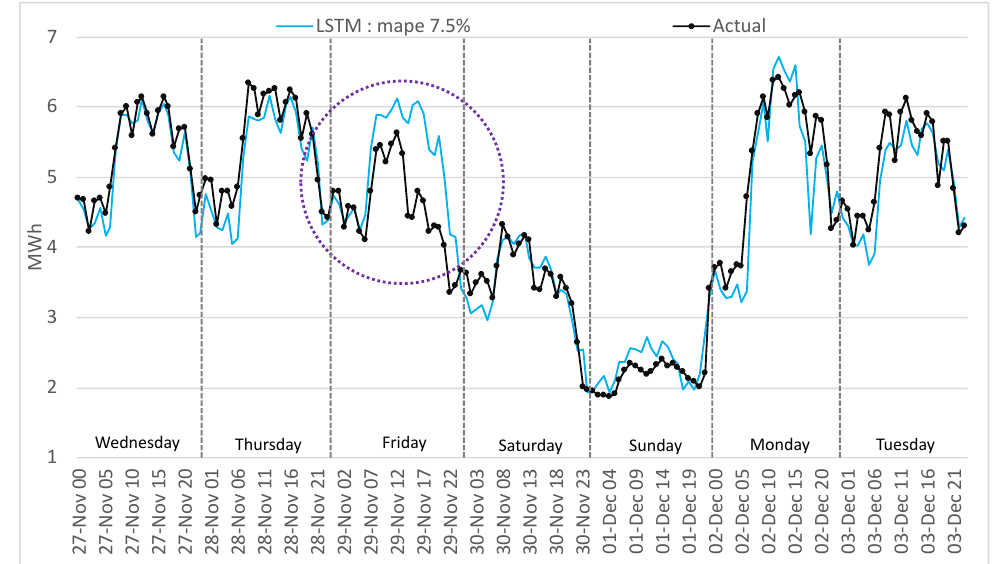
Figure 18. Comparison of actual with forecasted consumption—LSTM. For the mentioned period, disappointing results were obtained (12.3% MAPE) with the MLP algorithm, worse than the traditional methods. The LSTM performs worse by 23.2% than the GRU method because of the overfitting of the network on the training data. Using fewer epochs to train the LSTM resulted in underfitting the training data. The GRU is a simplified LSTM network, trains faster, and therefore generalizes better on the training data. In Figure 18, the LSTM method interprets Friday as a normal working day, and in Figure 19 the GRU manages to minimize the gap between the actual and the forecasted